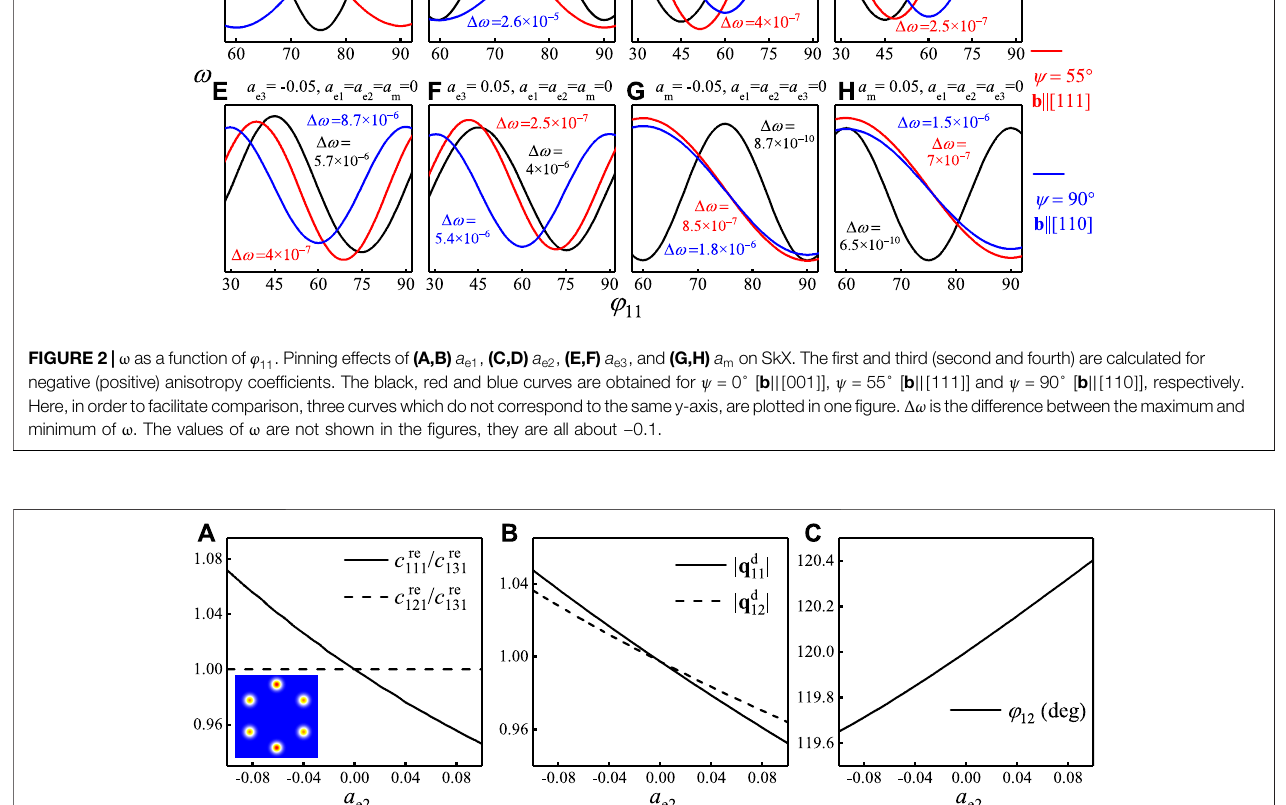
(cid:16)(cid:16)(cid:16)(cid:16) (cid:16)(cid:16)(cid:16)(cid:16) (cid:16)(cid:16)(cid:16)(cid:16) (cid:16)(cid:16)(cid:16)(cid:16) q d 11 q d 12 and ,and (C) theangle φ 12